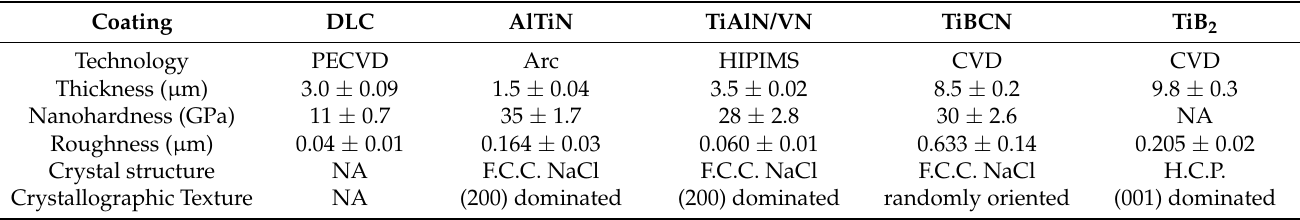
Table 1. Mechanical and crystallographic characterisation results.